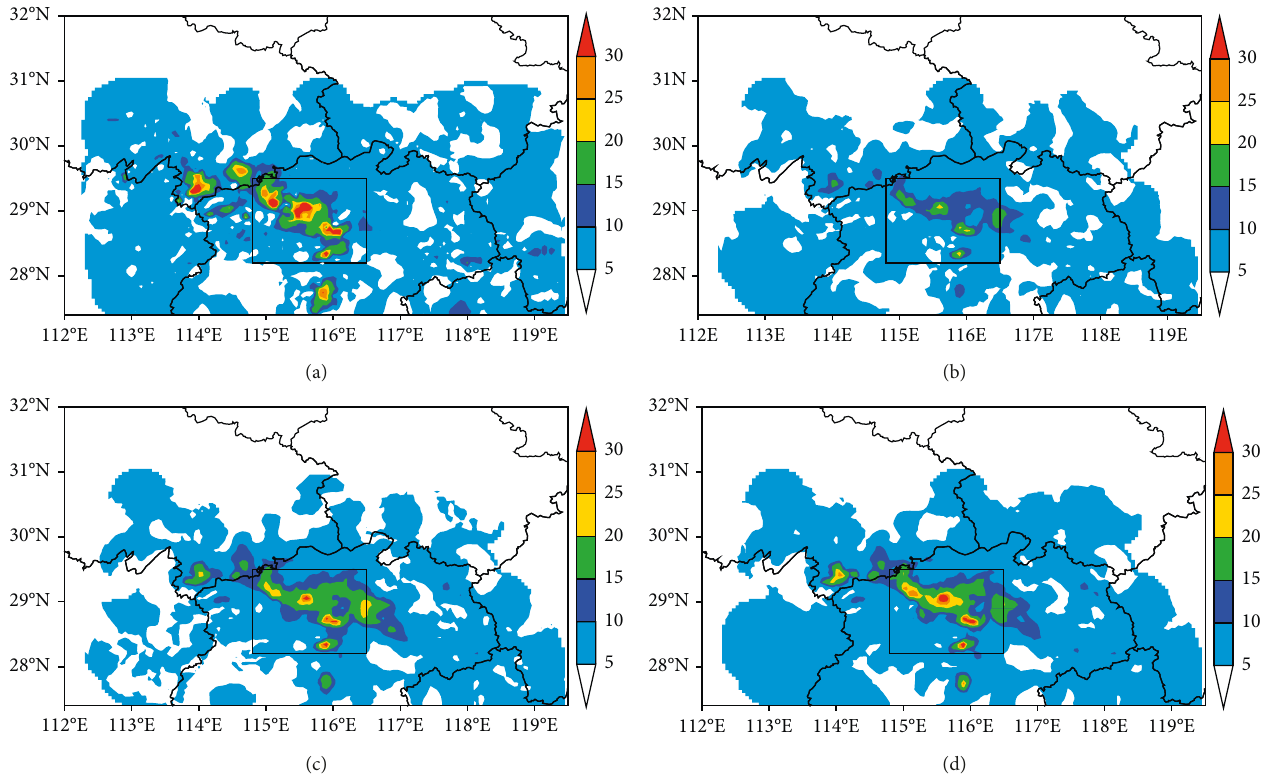
F IGURE 4: Precipitations (mm) obtained from (a) observation, (b) SM method, (c) EIDM method, and (d) ETDM method at 2200 UTC 1 June